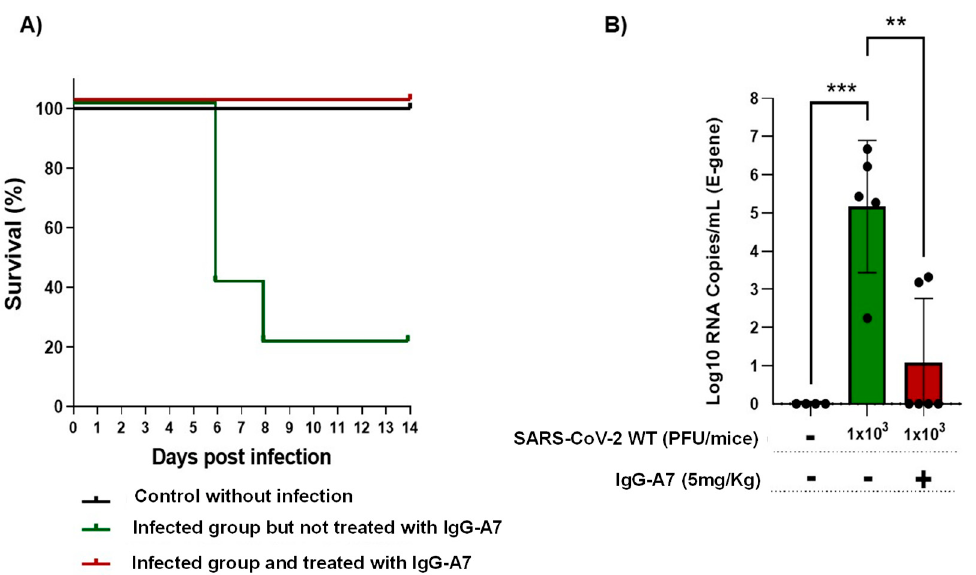
Figure 5. IgG-A7 protection of K18-ACE2 mice expressing hACE2 infected with SARS-CoV-2 WT. The efficacy of IgG-A7 was assessed through survival ( A ) and viral load ( B ) analyses. Statistics were performed through Kaplan Meier survival analysis (Chi 2 = 11.30, p = 0.0035) while viral load was performed by one-way ANOVA (F2,12 = 16.27) with Dunnett’s post hoc test (** p < 0.01; *** p < 0.001).